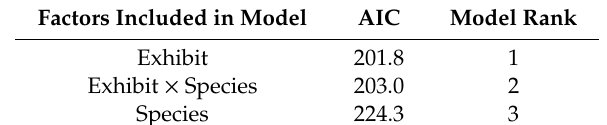
Table 2. Generalized linear mixed models (GLMMs) and associated Akaike Information Criteria (AIC)